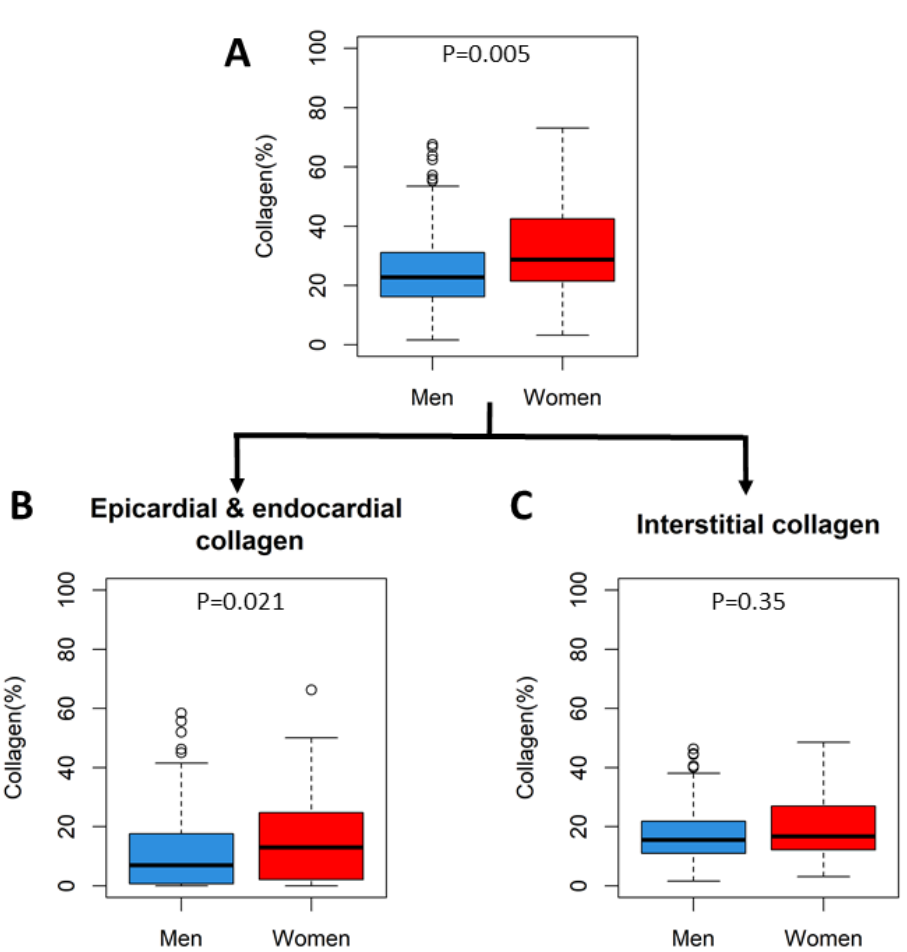
Figure 5. Percentage of collagen in Picrosirius red-stained histologic sections. ( A ) Total percentage of collagen in the histologic sections. ( B ) Percentage of epicardial and endocardial collagen, ( C ) Percentage of interstitial collagen.